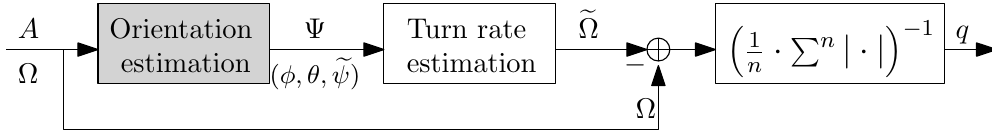
Figure 5. Estimation of the quality factor ( q ). The Orientation estimation block is part of any INS, and it implements a probabilistic filter. The heading estimated by this block is the one whose quality has to be